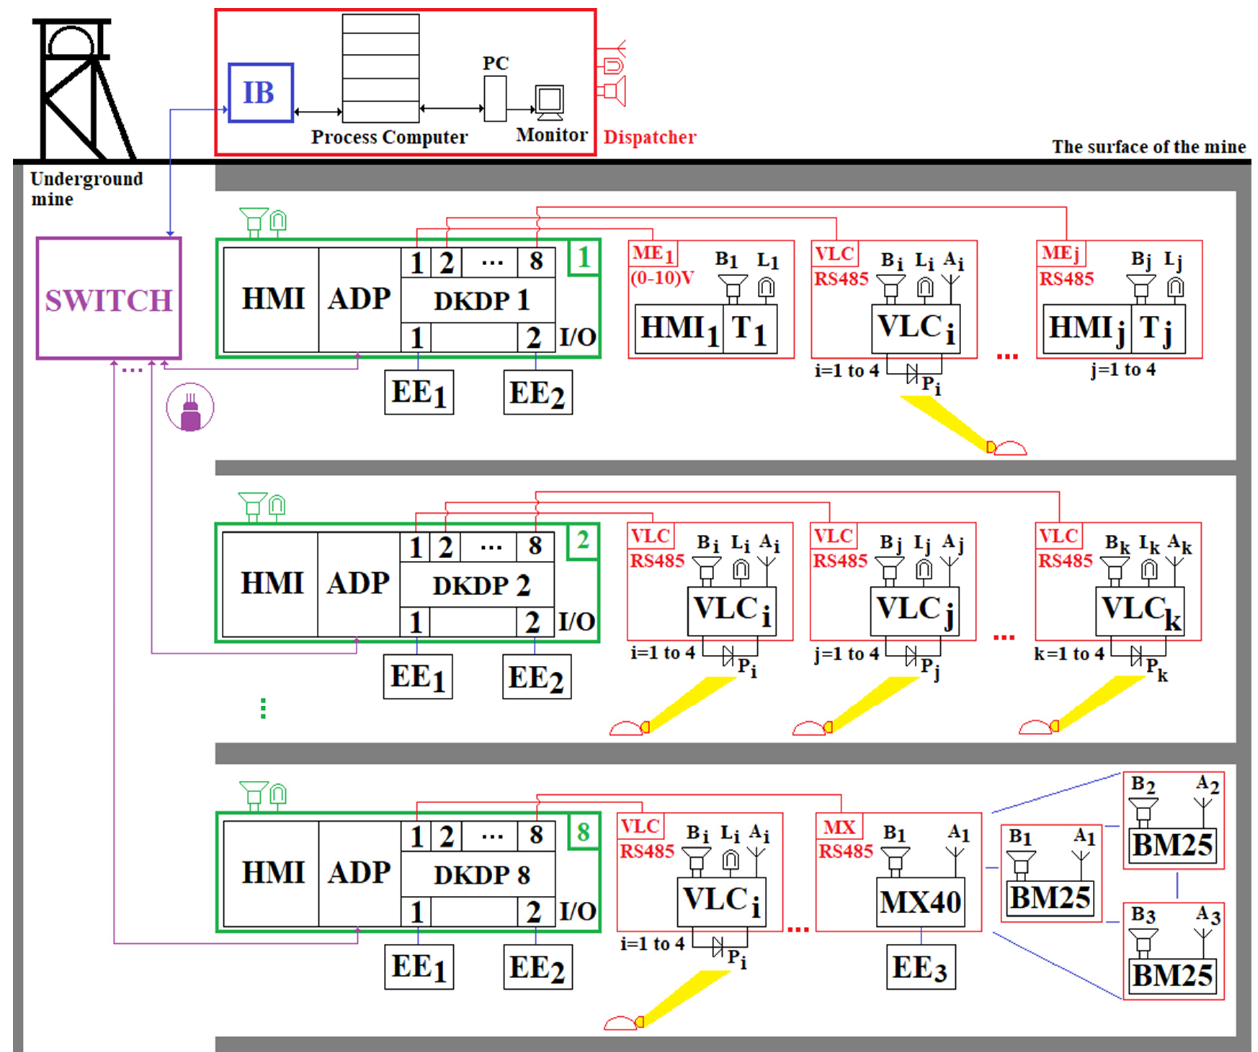
Figure 13. Hybrid personnel tracking and monitoring system of underground mining parameters based on VLC technology.